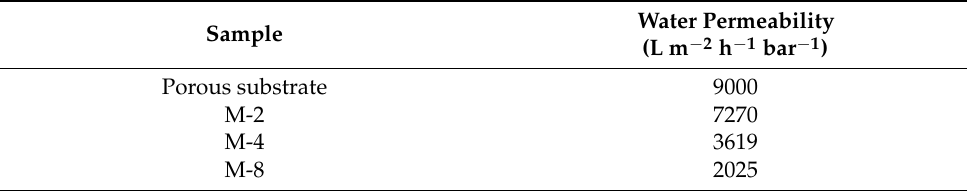
Table 7. Clean water permeability of M-2, M-4, and M-8